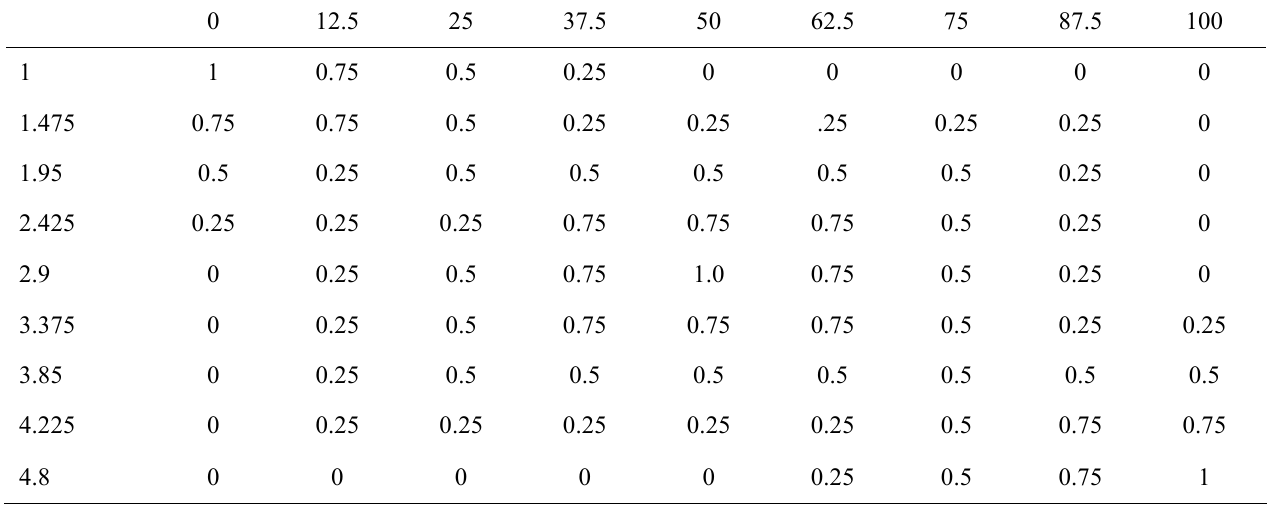
Table 6: Representation of rule 1 in matrix form